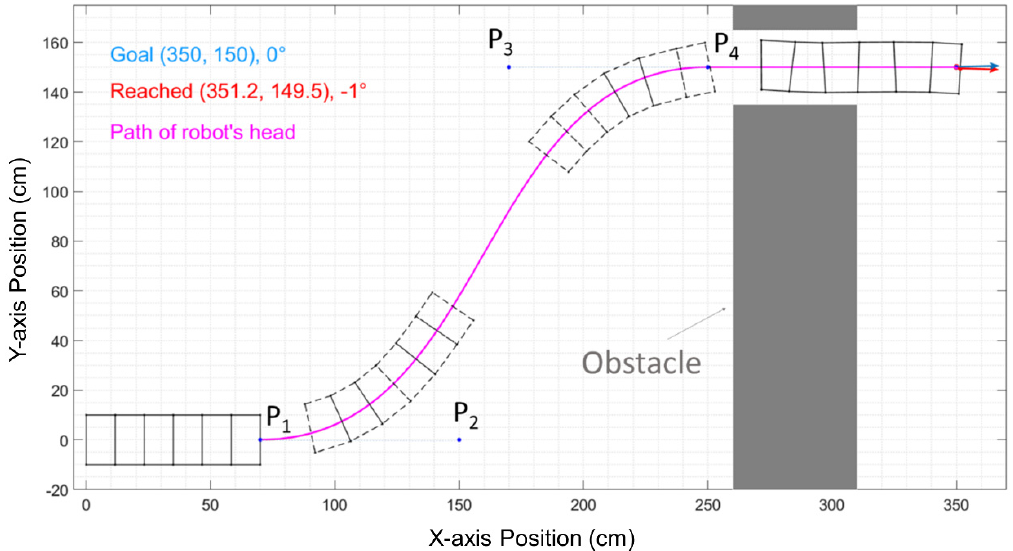
Figure 2. A worm-like robot passes through the obstacles solved by the Bézier curve path algorithm in our MATLAB simulation. The shape of the curve is controlled by points P 2 and P 3